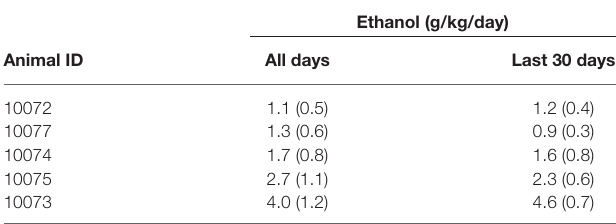
TABLE 1 | Average daily ethanol consumption over the duration of open-access conditions (375 days) and the last 30 days of access. Ethanol (g/kg/day) Animal ID All